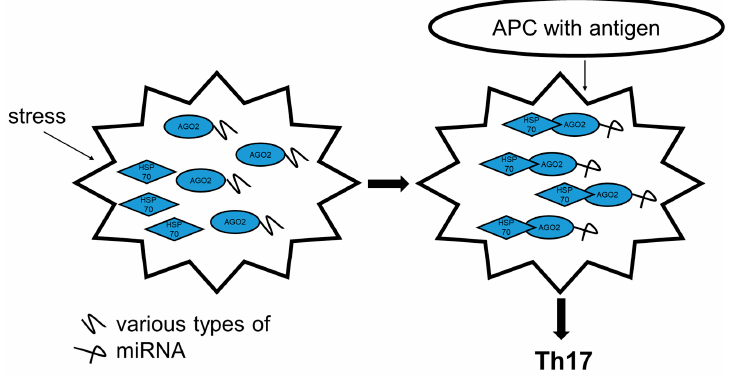
Figure 7. Proposed model of HSP70’s impact on Th cell fate. In conditions of stress, HSP70 is activated and forms a complex with AGO2. This complex has a different propensity for miRNA